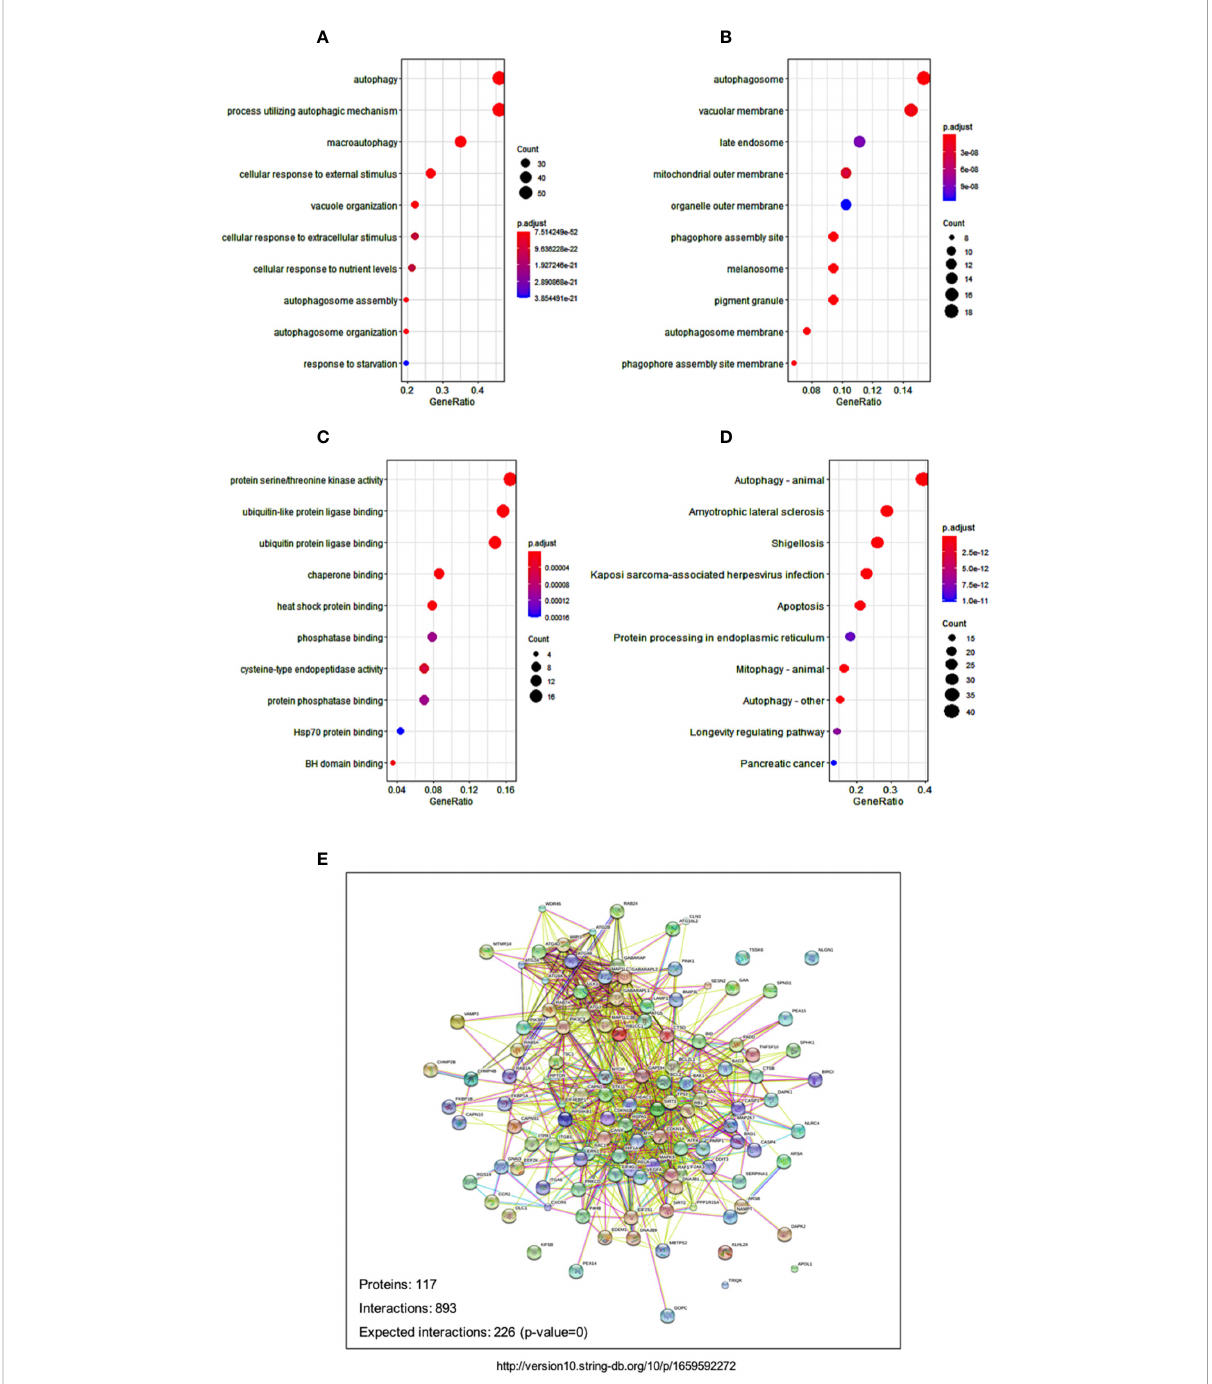
FIGURE 6 Signaling and networks related to autophagy-associated genes. (A-C) Dot plot reveals the GO enrichment of autophagy-associated genes, showing the signi fi cant biological pathways (A) , cellular components (B) , and molecular functions (C) , respectively. (D) Dot plot displays the signi fi cant pathways that were enriched in KEGG databases. Dot sizes denote the count number of enriched genes in the pathway, and dot color represents the adjusted p value of the enriched pathway. (E) Protein-protein interaction network shows the relationships among autophagy-associated proteins in the STRING